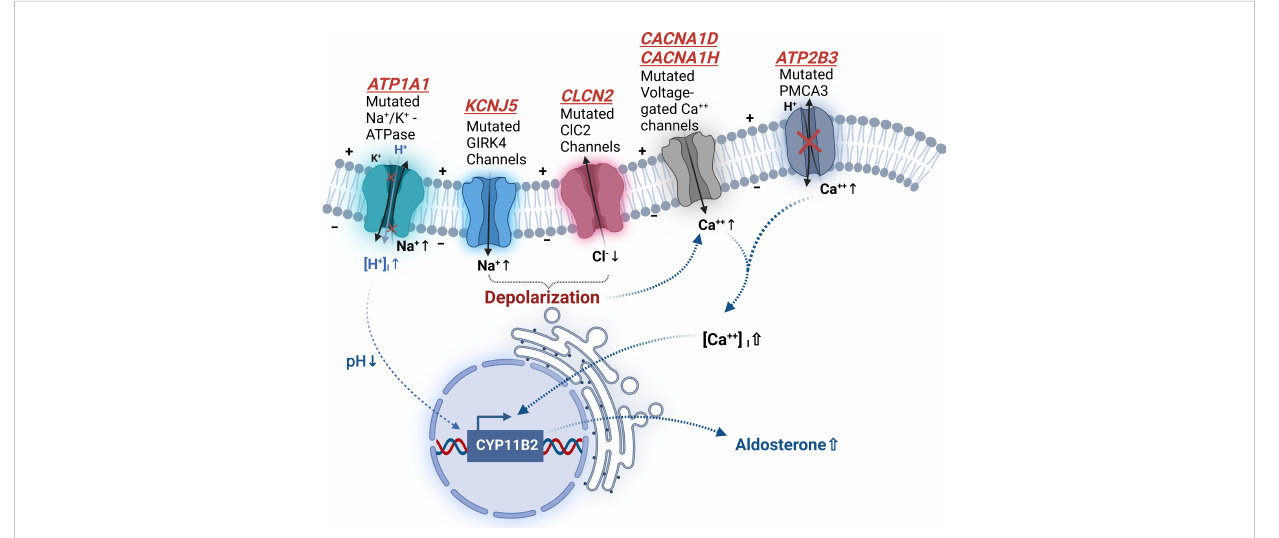
FIGURE 1 Somatic mutations related pathogenesis of aldosterone producing adenomas. *PMCA3: plasma membrane calcium-transporting ATPase